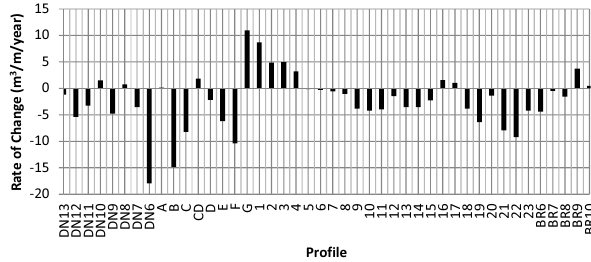
trends whose 95 % confidence intervals have the same